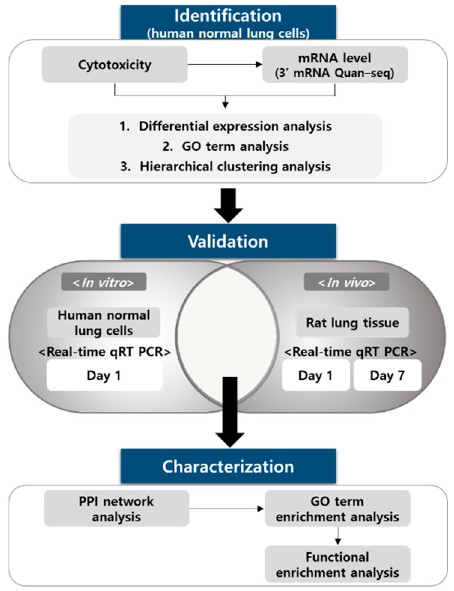
Figure 1. Workflow of the identification and characterization of biomarkers of sodium cyanide exposure. The DEGs after sodium thiocyanate exposure were analyzed via transcriptomic analy- ses. Then, the candidate mRNA biomarkers were validated at various treatment doses and time points in vitro and in vivo. For biomarker characterization, the network analysis of biomarkers, GO term, and functional enrichment analysis were performed. DEG, differentially expressed gene; GO, gene